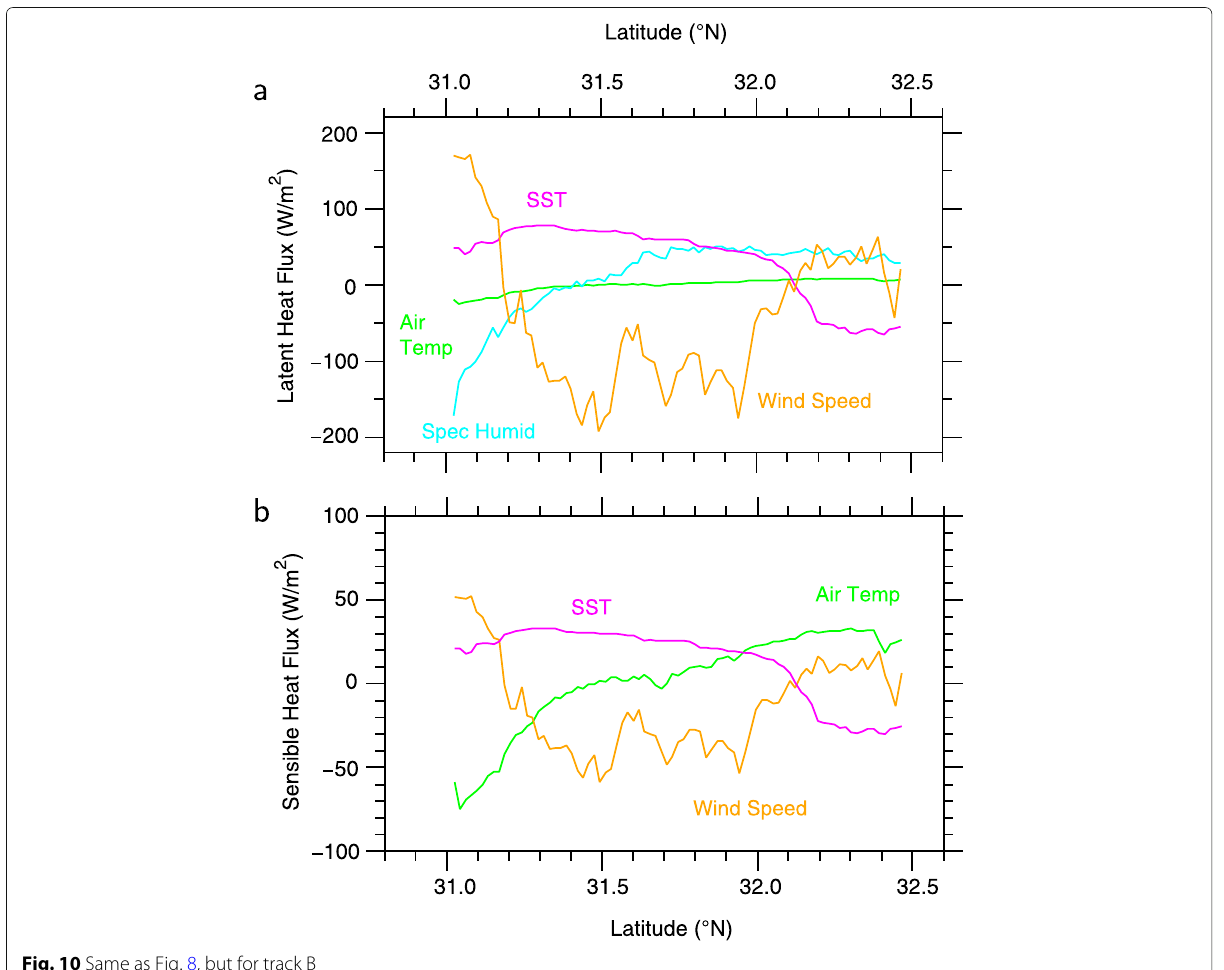
Fig. 10 Same as Fig. 8, but for track B